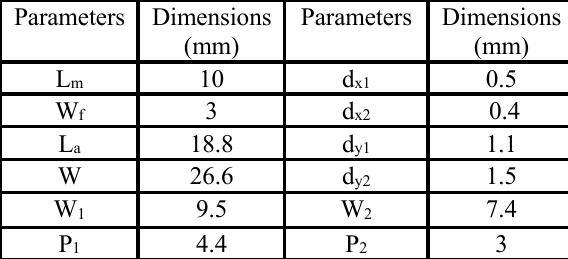
Fig.6 (a) Geometry of proposed antenna, (b) Photograph of the proposed tri-band antenna Table 1: Dimensions of the proposed antenna Parameters Dimensions Parameters